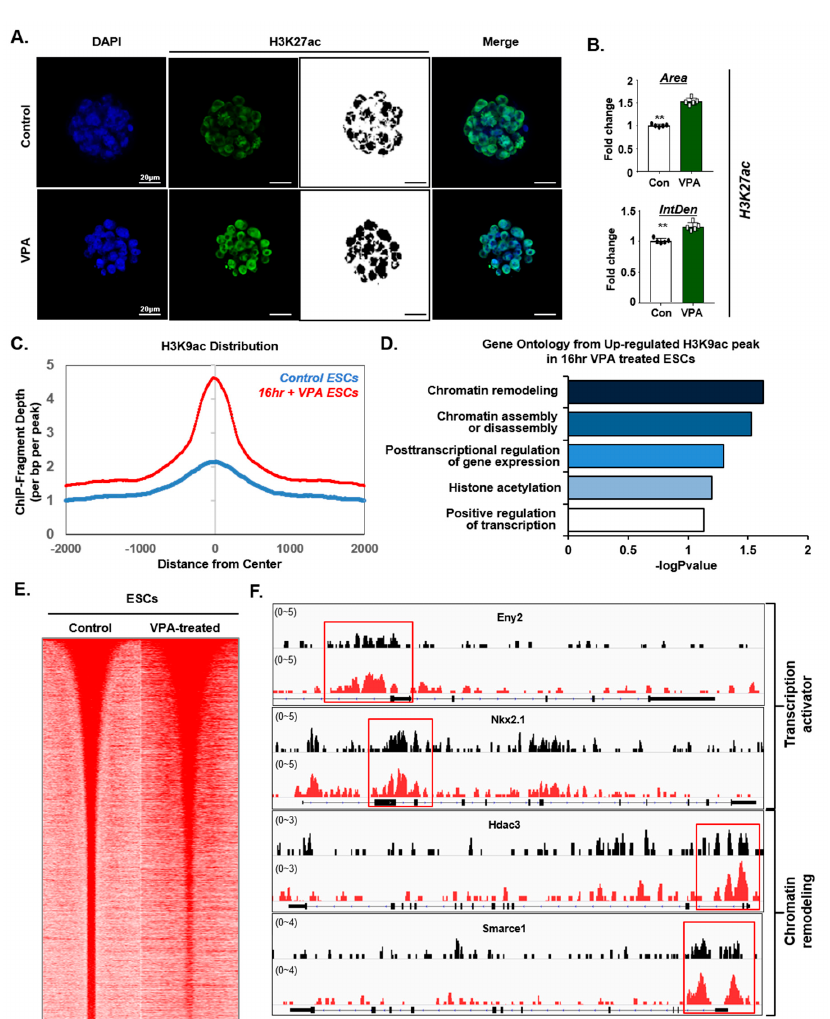
Figure 4. VPA increases acetylation and occupancy on pluripotent genes. ( A ) Immunofluorescence of H3K27ac in mouse blastocysts before (control) or after VPA ‐ treatment. ( B ) Quantification of the H3K27ac ‐ positive area and intensity in mouse blastocysts. Data were expressed as mean ± SD, n = 5. ** p < 0.01, two ‐ sided Student’s t ‐ test. ( C ) H3K9ac ChIP ‐ seq enrichment occupancies of the control samples or those treated with VPA for 16 h. Enrichments were plotted ±2 kb around the TSS in mESCs. Y ‐ axis represents the depth of ChIP ‐ fragment. ( D ) Gene ontology (GO) enrichment analysis of the H3K9ac upregulated genes, with 16 h of VPA ‐ treatment in mESCs. ( E ) Heatmaps represent relative ± 2 kb around H3K27ac peak levels from mouse ESCs whole ‐ genome before (control) or after VPA ‐ treatment. ( F ) Genome browser tracks show the occupancy of transcription activator and chromatin remodeling near Eny2, Nkx2.1, Hdac3, and Smarce1 loci. The image in A is representative of ≥ 3 similar experiments.